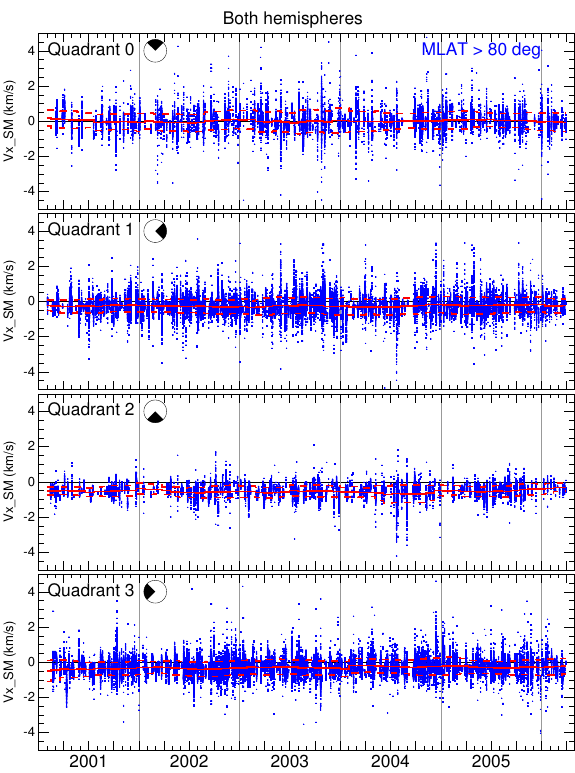
Fig. 6. 62 months of mapped EDI drift measurements in X SM direction within the central polar cap region (magnetic latitude | φ m | > 80 ◦ ), plotted as condensed time series for the four different quadrants of the IMF clock angle distribution. As indicated with the small circle inlet for each respective panel, quadrant 0 of clock angle distribution comprises ± 45 ◦ centered around 0 ◦ clock angle, quad- rant 1 the same angular width centered around 90 ◦ , and so forth. Boxcar averages (6 month centered window) are shown as red lines and their standard deviations are indicated by the dashed red lines. Table 2. Average values of the sliding boxcar mean values for 62 months of mapped EDI drift measurements in X SM direction (red lines in Fig. 6) and their average standard deviations for each quad- rant of the IMF clock angle distribution individually. Fig. 7. Top: Polar cap potentials as a function of clock angle for the Northern (blue) and Southern (red) Hemisphere. The clock angle range is divided in 16 steps of equal width (22.5 ◦ ). The potentials in this panel are derived from the full high-latitude ( > 58 ◦ ) convection pattern for each bin, as explained in Paper 1. Middle: The av- erage convection velocities h V i , h− V x i , and h V y i (dashed) within the central polar cap at magnetic latitudes | φ m | > 80 ◦ as function of clock angle, using the same colour coding and bin-step widths as above. Bottom: coverage characteristics for each bin individually. The solid lines, which refer to the middle panel, show the relative number of data points within the high-latitude circle ( > 80 ◦ ) for each bin, as percentage of the maximum number noted within the panel. The dashed lines refer to the upper panel, indicating the percentage of valid grid points of the full area of the polar cap potential pattern construction.